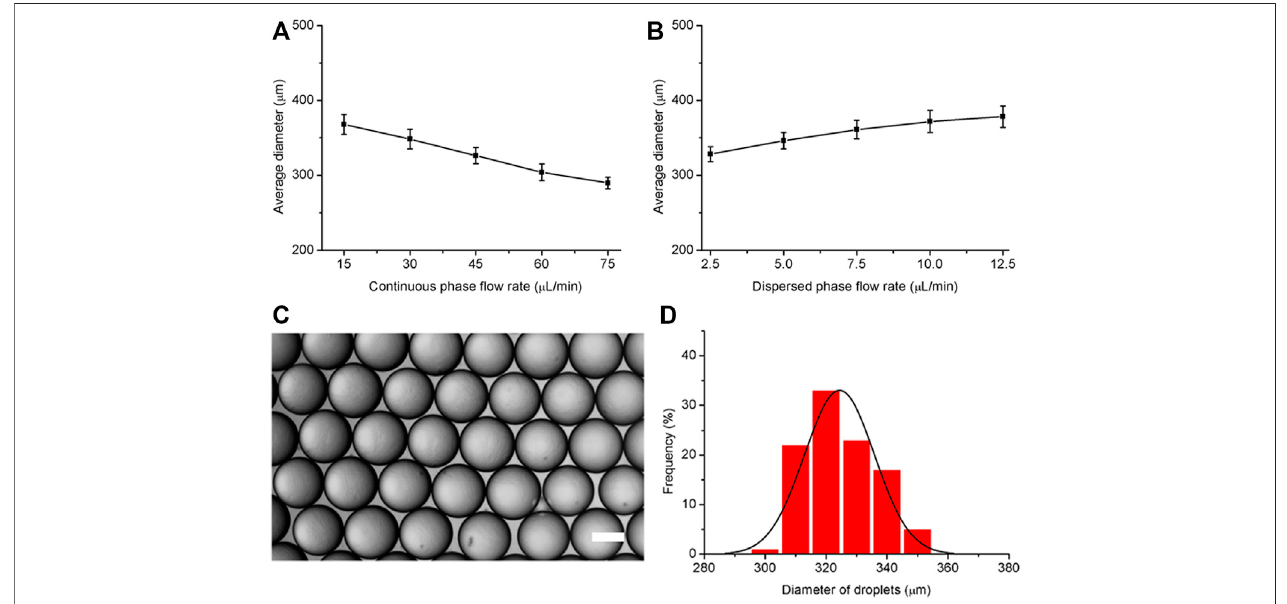
FIGURE 2 | Effects of the disperse phase and continuous phase fl ow rates on the diameter of generated droplets. (A) Variation in droplet diameter with increasing continuousphase fl owratefrom15to75 μ l/min(dispersephase fl owrate:5 μ l/min). (B) Variationindropletdiameterwithincreasingdispersephase fl owratefrom2.5to 12.5 μ l/min (continuous phase fl ow rate: 30 μ l/min). (C) Representative microscopy image of droplets generated by the micro fl uidic system. (D) Size distribution of the droplets. The scale bar represents 200